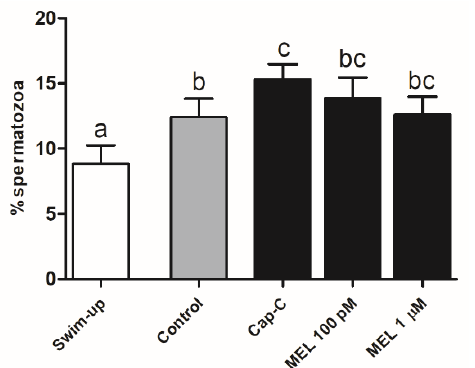
Figure 9. Percentage of live sperm with high nitric oxide levels (PI-/DAF+) assessed by flow cytometry before (swim-up, white bars) and after in vitro capacitation without (control, grey bars) and with cAMP-elevating agents (Cap-C, black bars) and with L-arginine (L-arg, 10 mM) or L-NAME (100 µM or 1 mM). Data are shown as mean ± S.E.M ( n = 7). Different letters indicate significant differences ( p < 0.05).